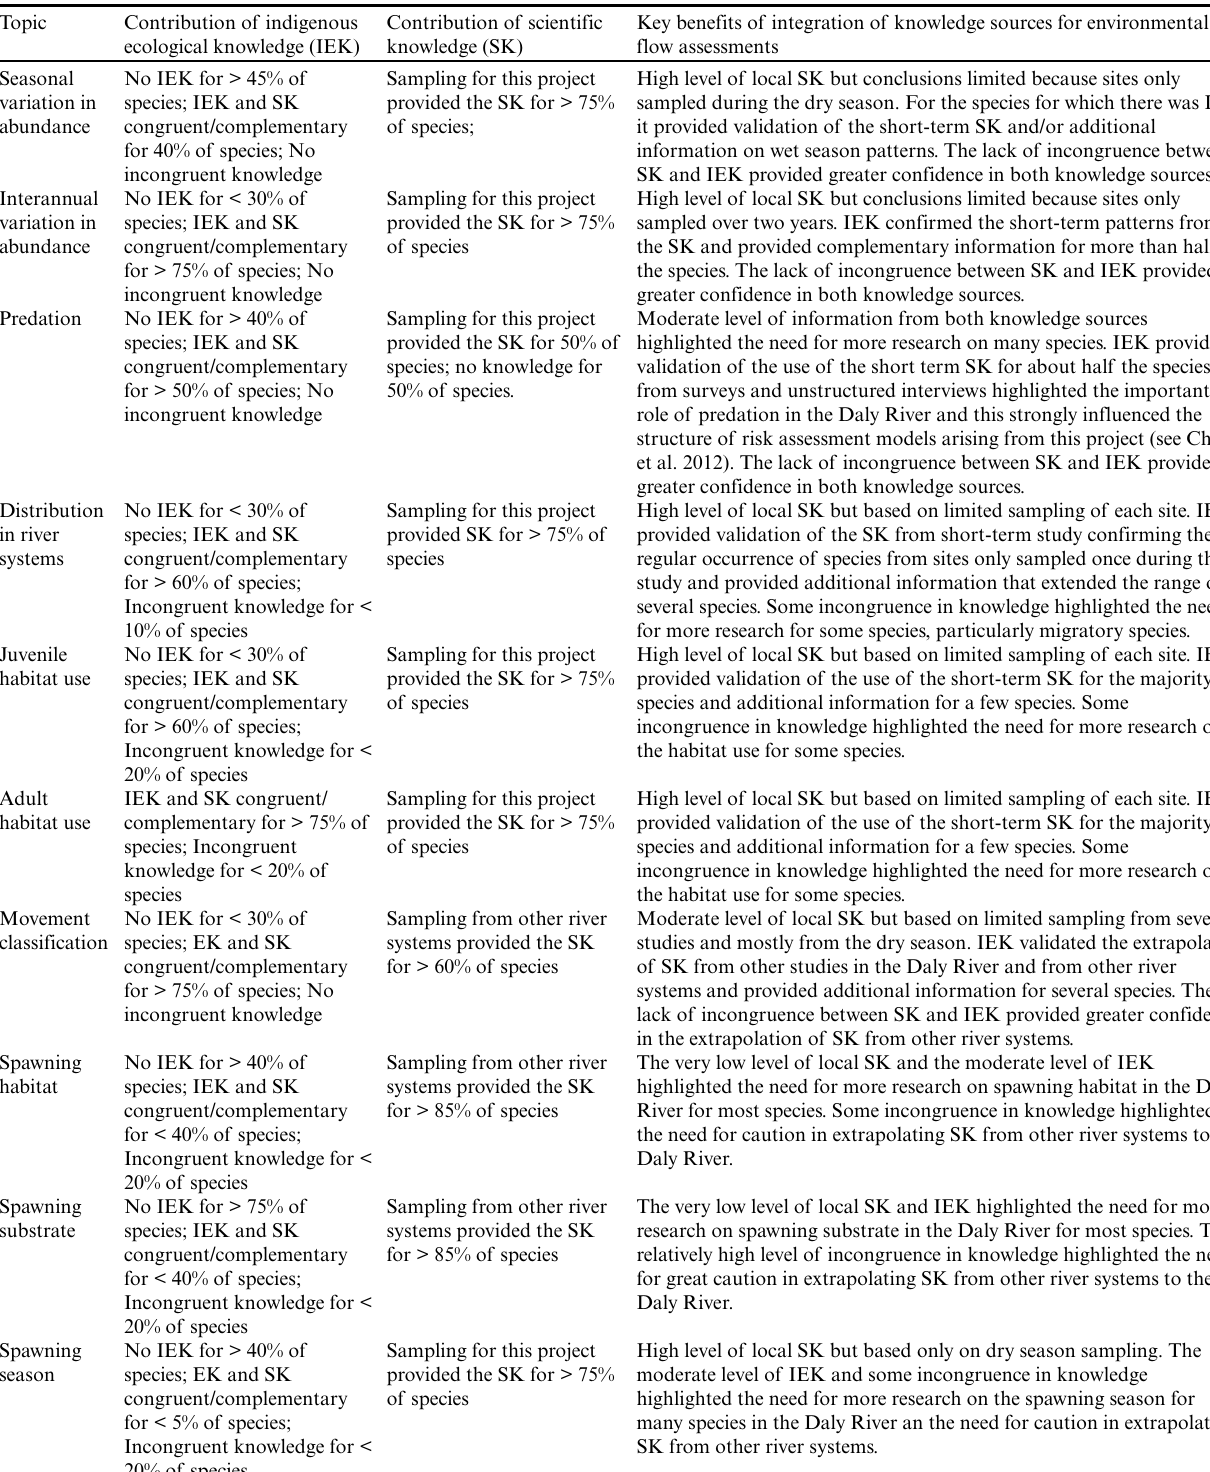
Table 3 . Table 3. Assessment of the contribution of indigenous ecological knowledge (IEK) and scientific knowledge (SK) and the potential benefits of their integration for environmental flow management of fish in the Daly River. Assessments are based on the data from Figures 3a,b and 4a,b. IEK was assessed against existing SK available at the time of the interviews (Figure